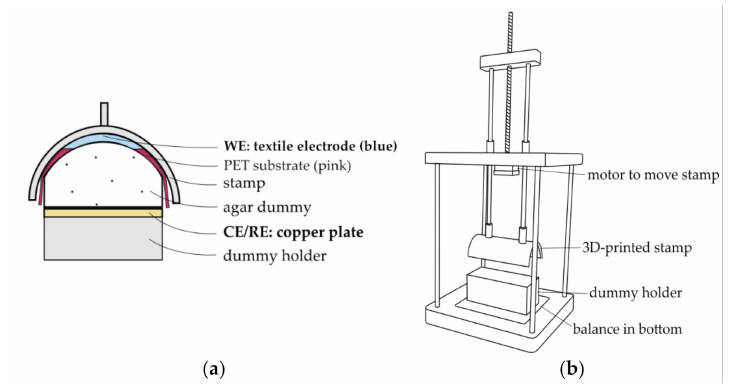
Figure 5. ( a ) Side-view of the dummy setup in Series II. ( b ) Testing rig for Series